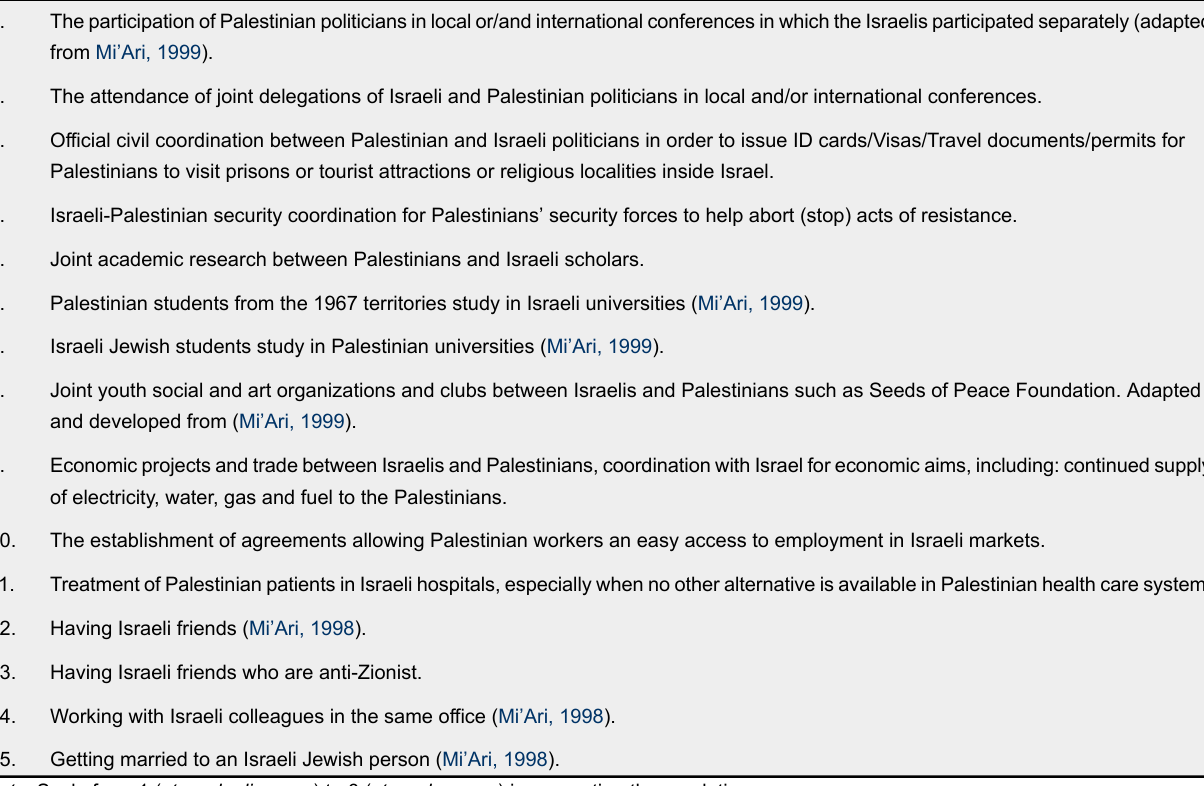
15-Item Scale of Forms of Intergroup